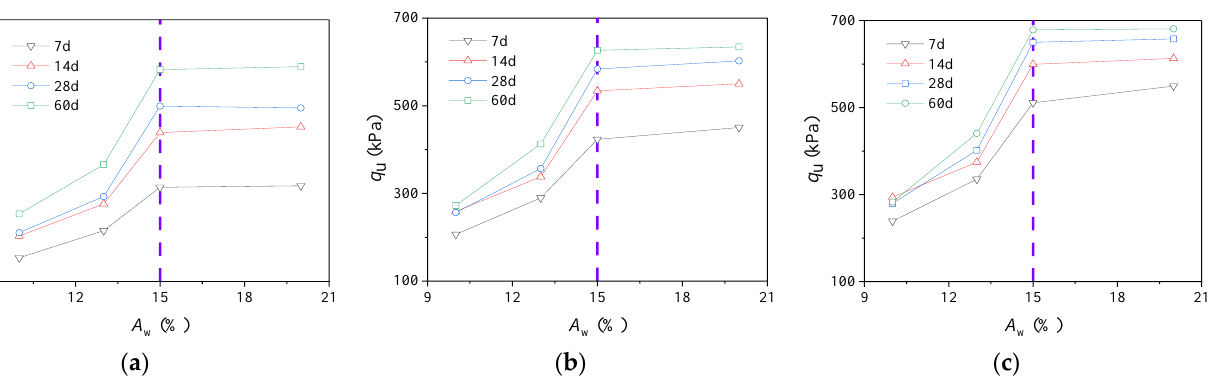
Figure 6. SEM images at different C HA (at a magnification of 20K): ( a ) C HA = 0%; ( b ) C HA = 4%; ( c ) C HA = 7%.